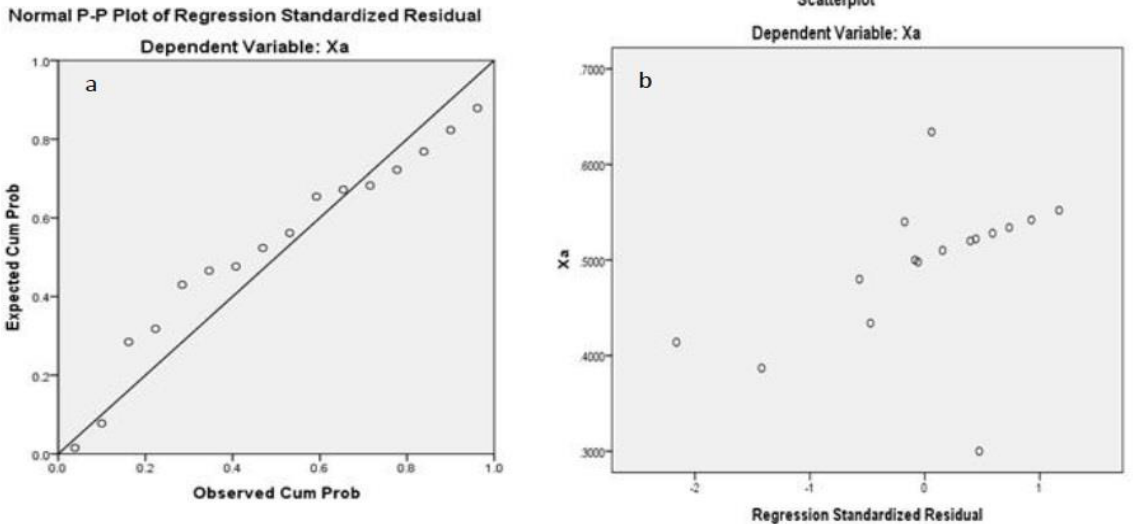
Figure 1. ( a ) Expected versus observed probability of reaction conversion; ( b ) Scatter plot of optimizing reaction conver- sion.